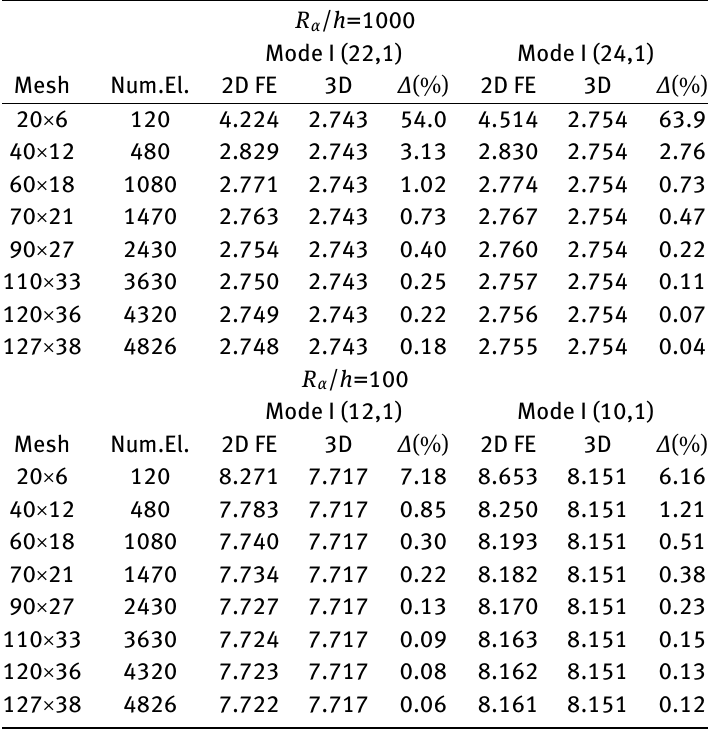
Table 7: Third assessment for the 2D FE solution, simply supported composite cylinder 90 ∘ /0 ∘ /90 ∘ with thickness ratios R α / h =1000 and R α / h =100. First two frequencies in Hz, comparison between the present 3D exact solution and the 2D FE solution via Nastran. The error is calculated as ∆ (%) = FE −3 D × 100 3 D